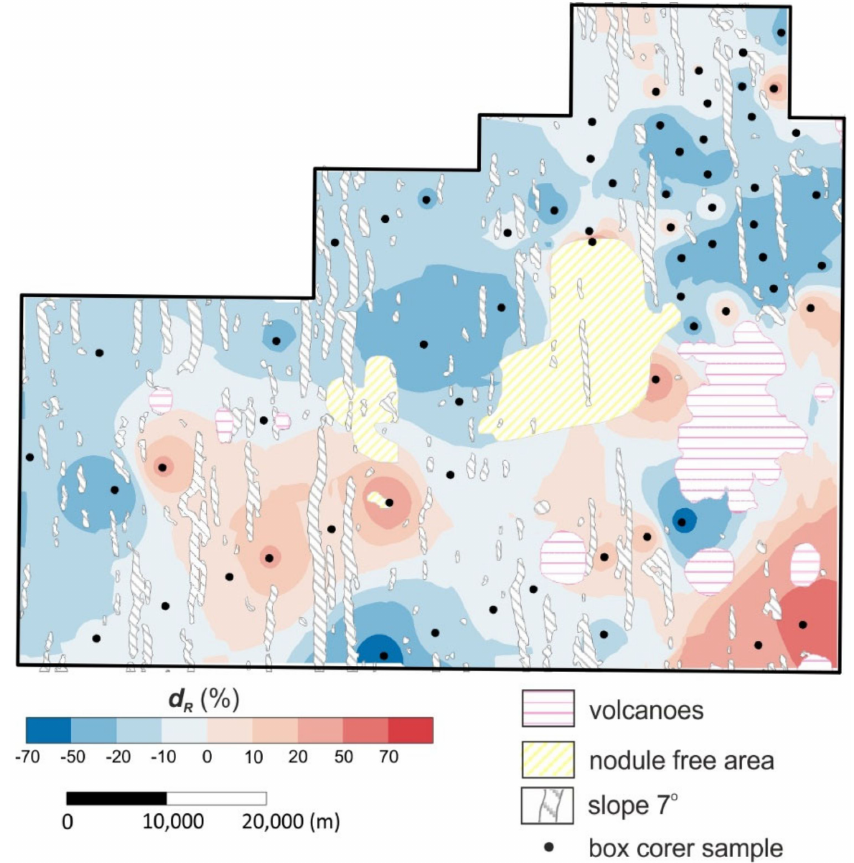
Figure 4. Contour map of relative di ff erences (d R ) between percentage nodule coverage of the seafloor (NC-S) and the grid